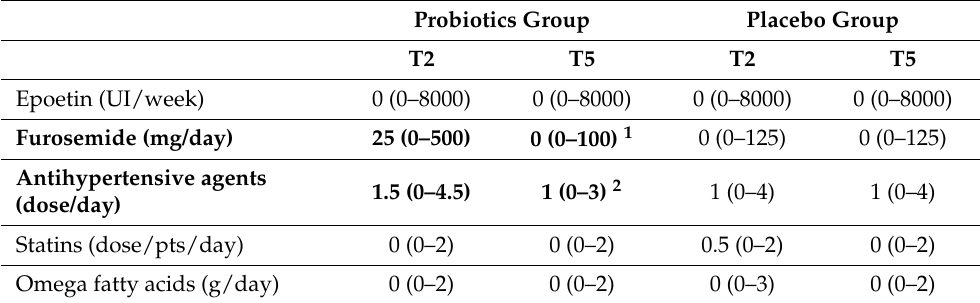
Table 5. Changes in pharmacological therapy. Values are presented as median